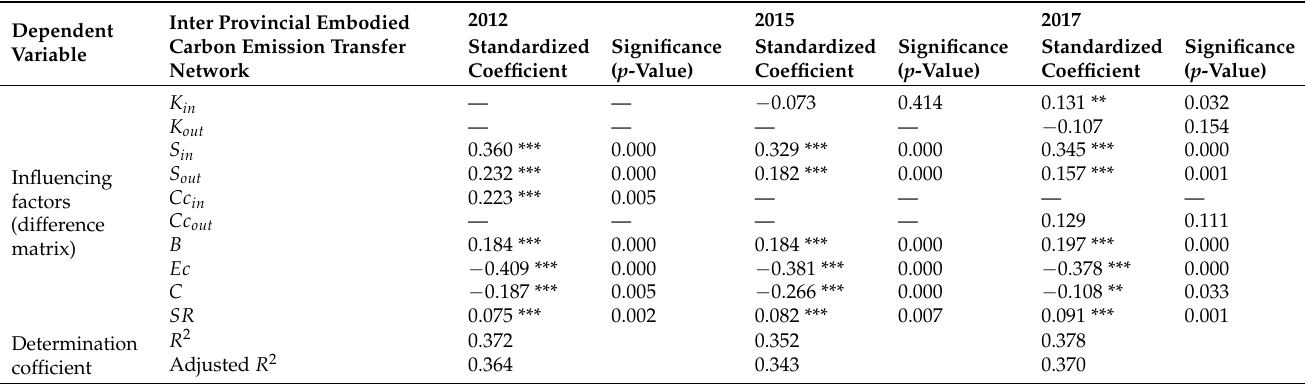
Table 6. QAP regression analysis results of